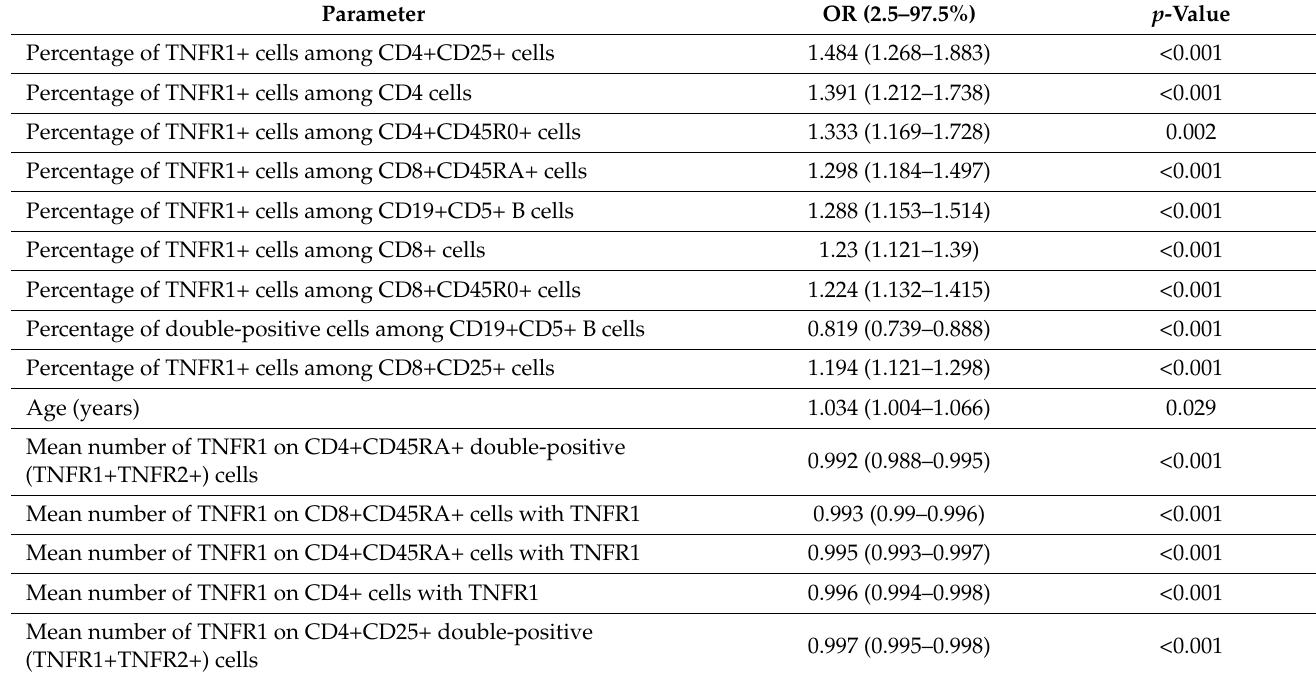
Table 2. Results of univariate logistic regression analysis.